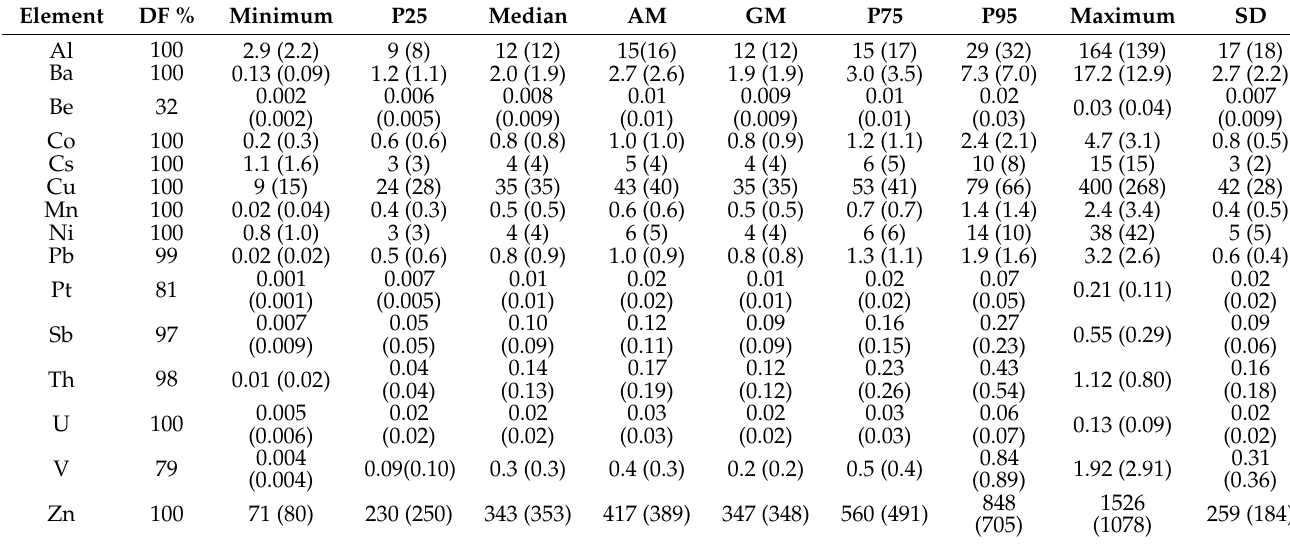
Table 2. Frequency of detection and levels of elements ( µ g/L) in the urine of women from the Valencian Region (N = 119) 1 . Creatinine-adjusted urinary levels ( µ g/g creat) 1